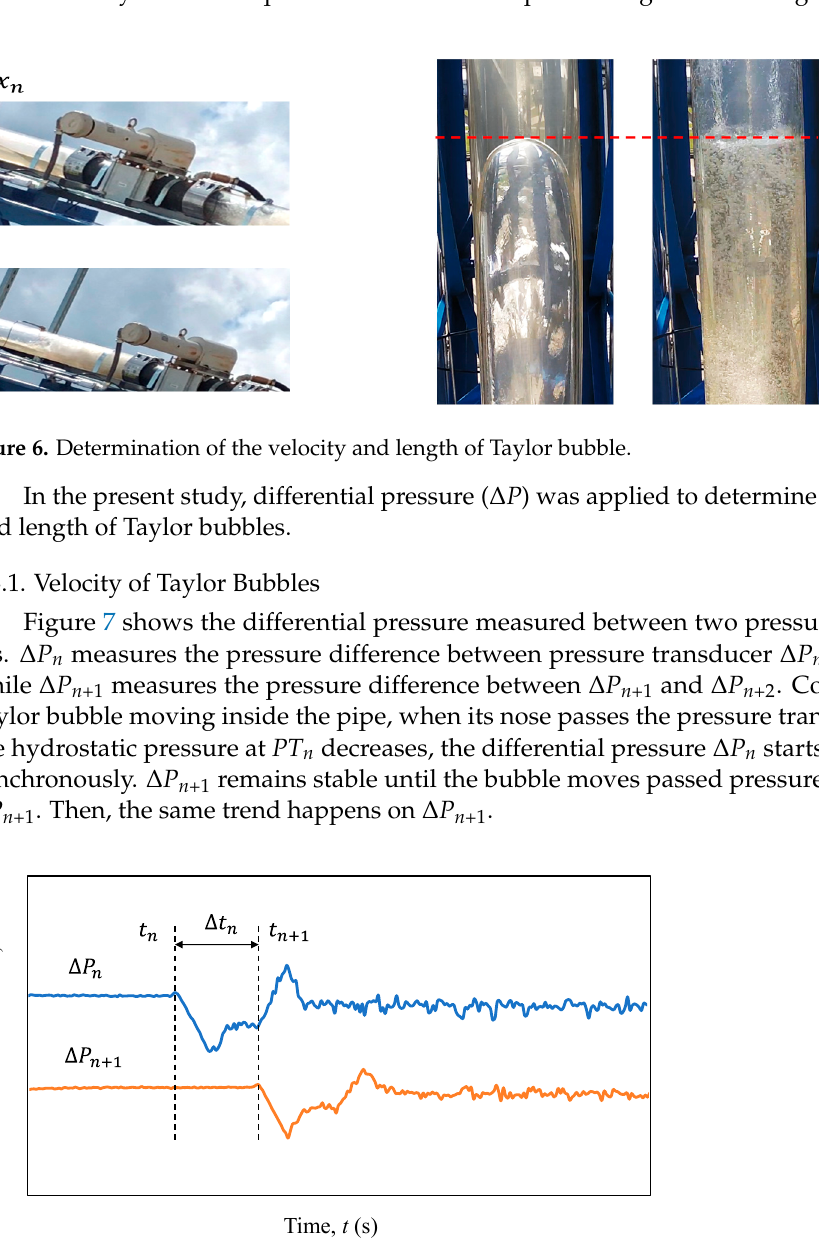
Figure 7. Differential pressure to determine the velocity of Taylor bubbles.